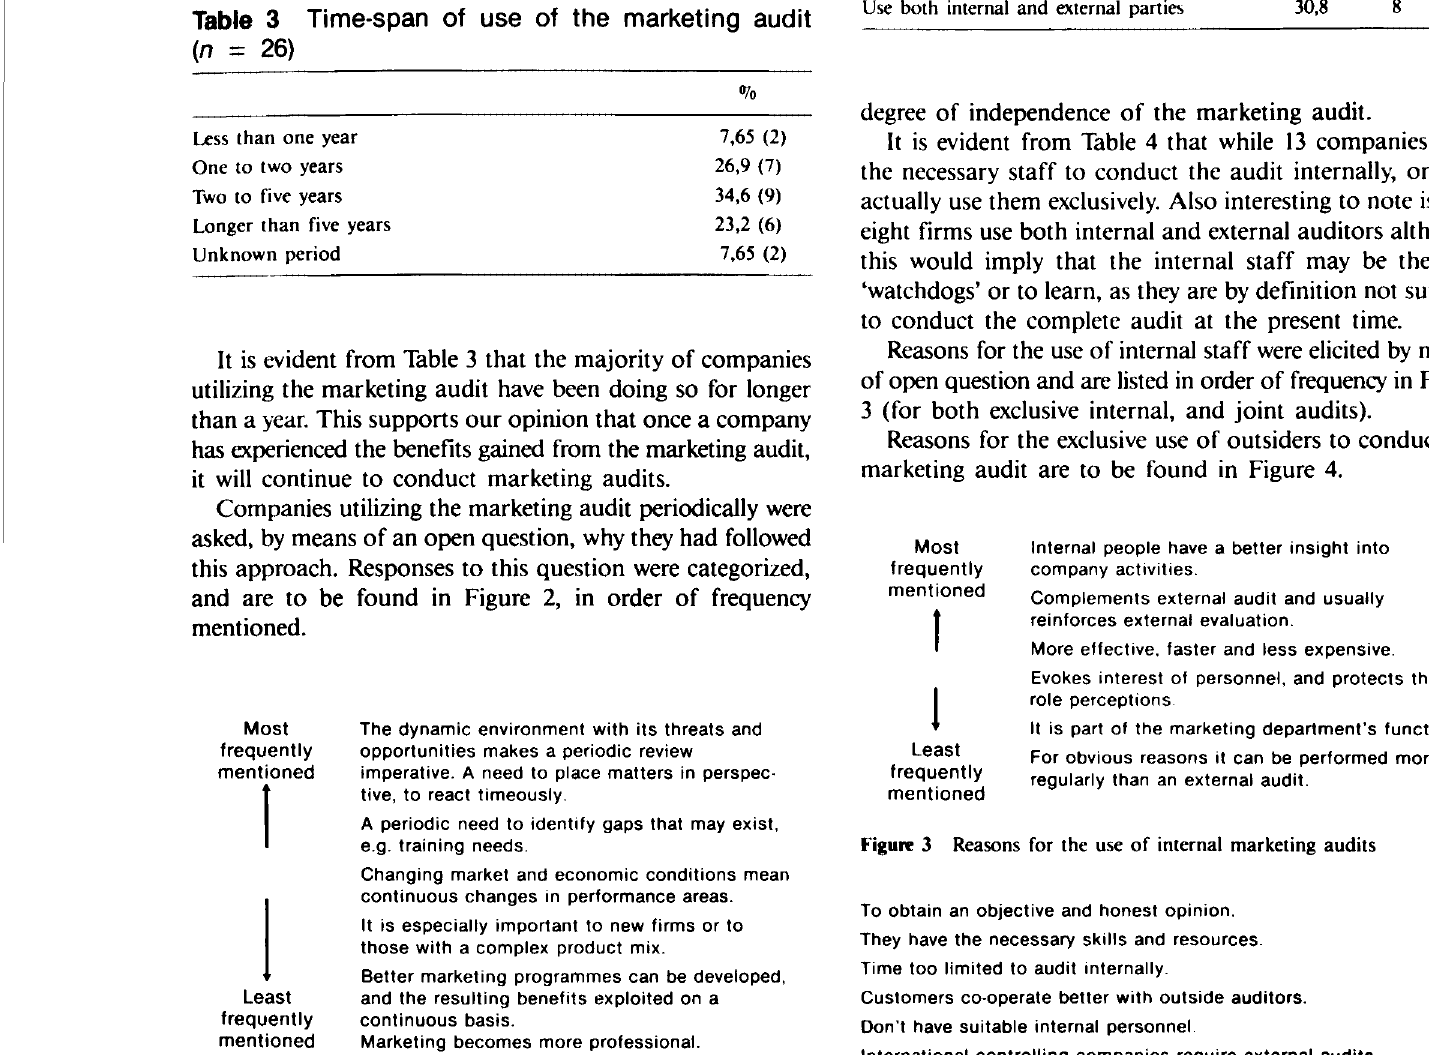
Figure 2 Reasons for periodically conducting the marketing audit